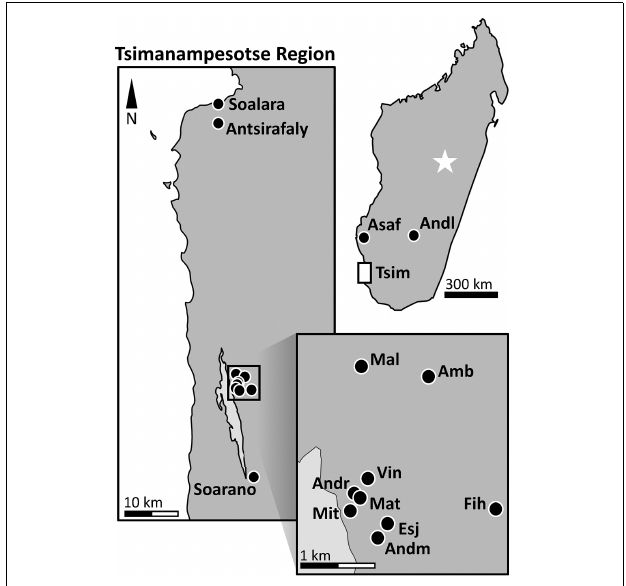
FIGURE 1 | Fossil and stalagmite site names and abbreviations. Map of Madagascar: Asaf, Asafora Cave; Andl, Andranomilitsy Cave; Tsim, region of the Tsimanampesotse National Park. The star represents the capital of Madagascar, Antananarivo. Vertical rectangular blowout box: Town of Soalara and nearby lacustrine site Antsirafaly; Soarano Cave is indicated near the southernmost end of Lake Tsimanampesotse. Square blowout box: Amb, Ambolely Sinkhole; Andm, Andriamaniloke Cave; Andr, Andranohilova Cave; Esj, Esajo Cave; Fih, Fihamy Cave; Mal, Malazamanga Cave; Mat, Maty Cave, or Anjohimpaty Rock Shelter; Mit, Mitoho Cave; Vin, Vintany